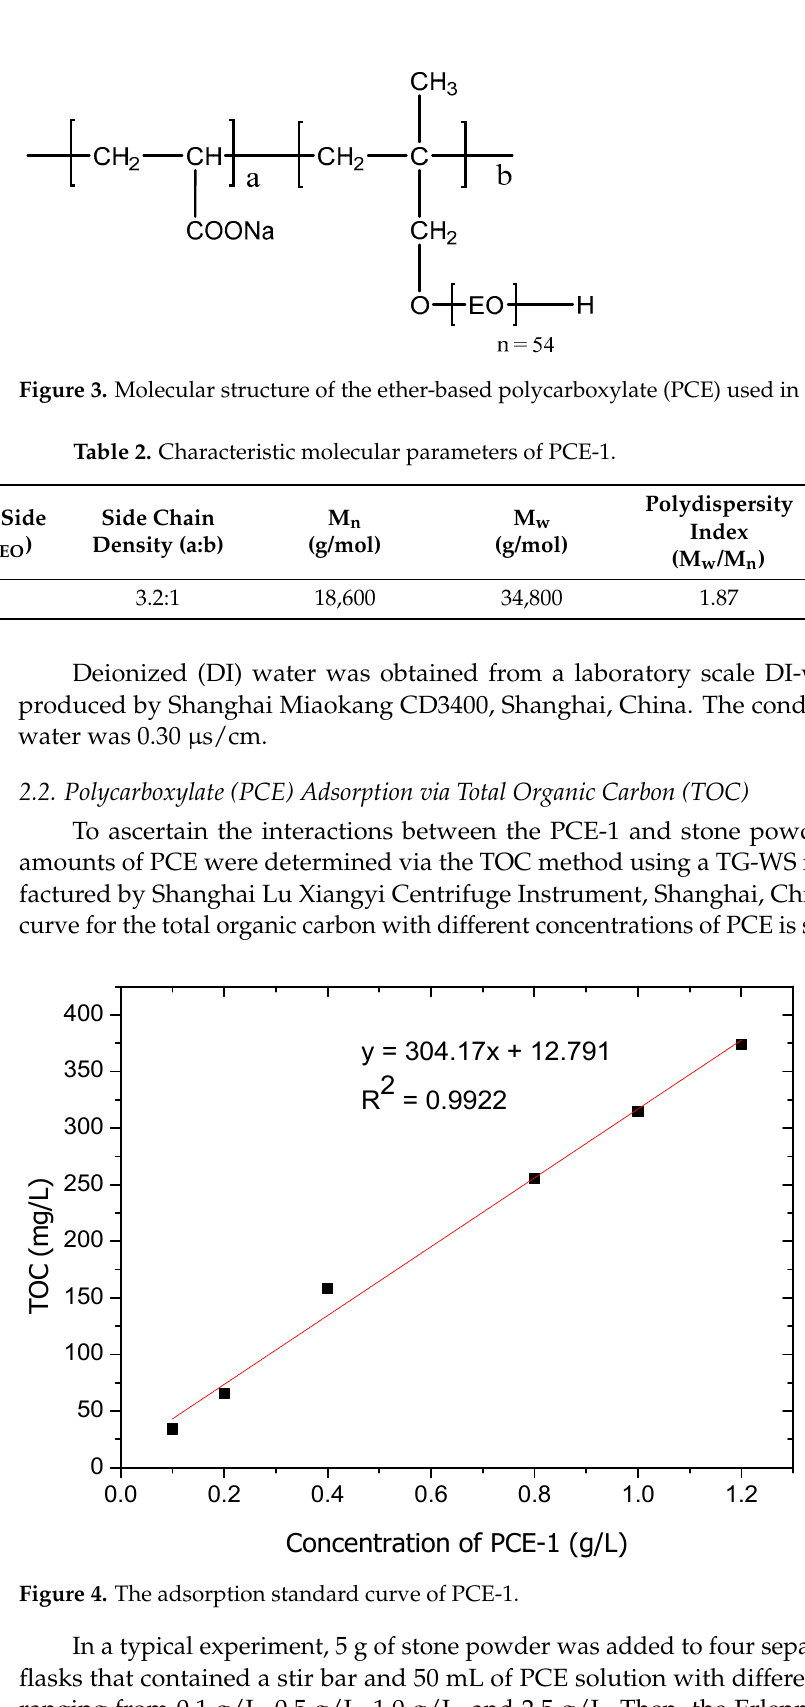
Figure 2. X-ray diffraction (XRD) patterns of stone powder.